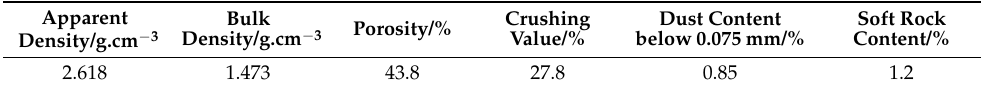
Table 1. Chemical elements of coal gangue (atomic fraction)/wt.%. Figure 4. Microstructure of coal gangue. O C Fe Table 2. Physical and mechanical properties of coal gangue coarse aggregate (wt.%). Apparent Density/g.cm − 3